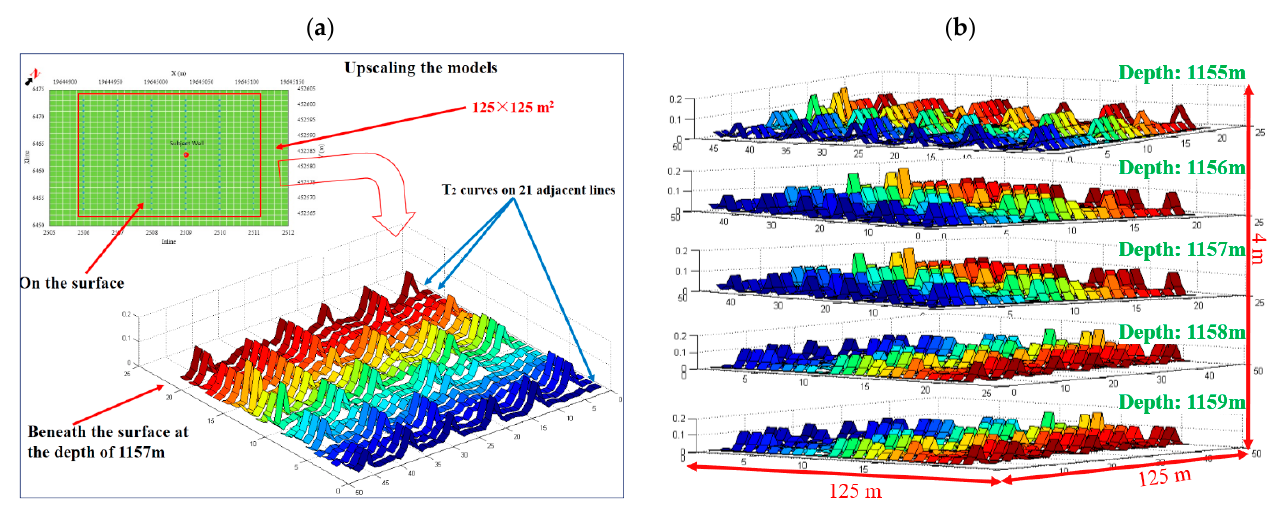
Figure 13. ( a ) The finally simulated T 2 curves in the depth of 1157 m and their corresponding position on the surface; ( b ) Simulated T 2 curves at various depths of the reservoir which could be estimated for any desired area around the well as far as no considerable geological changes happen.